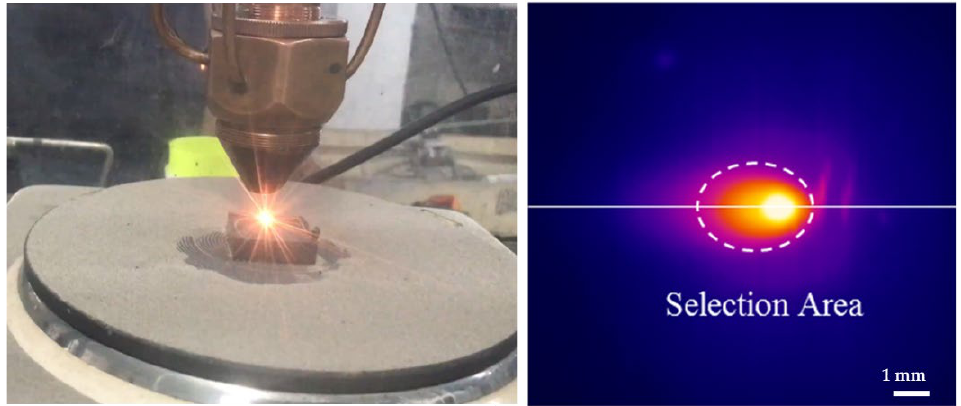
Figure 3. Laser-cladding process and infrared image of the laser hot spot on the substrate taken by an IR camera.